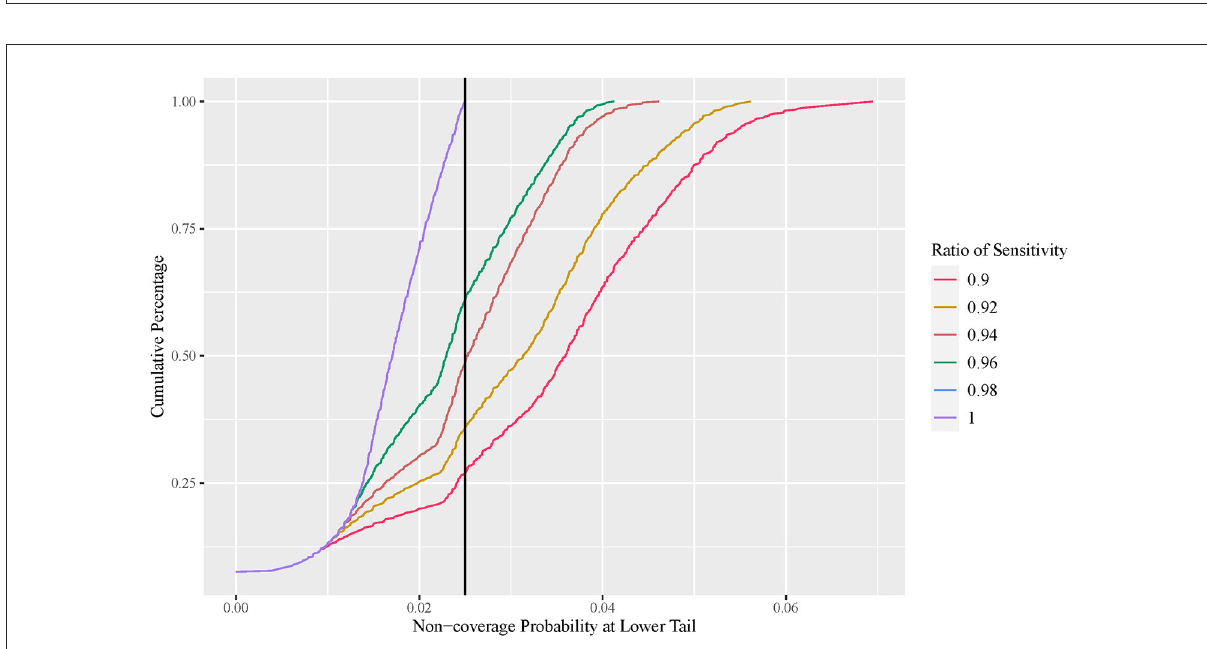
FIGURE4 Cumulative percentage plot of one-sided non-coverage probability at lower tail with variable ratio of sensitivity (exact conditional method).